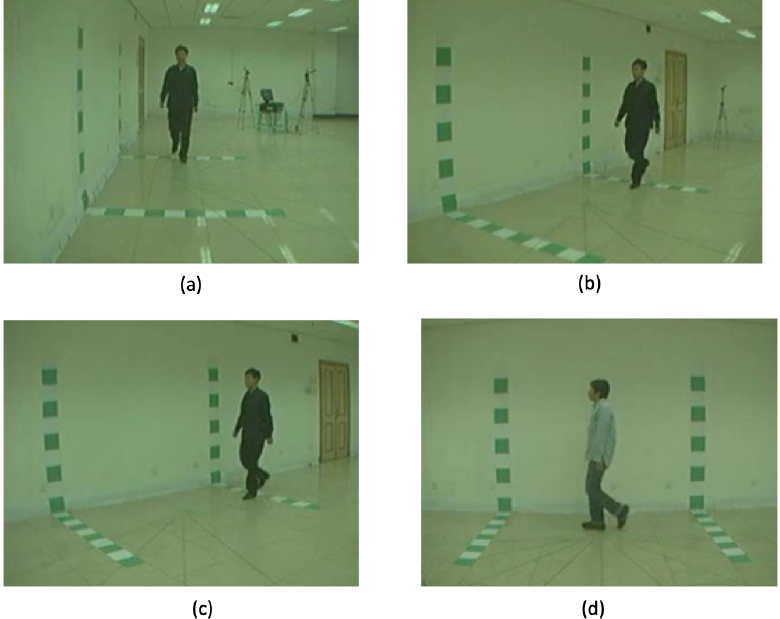
Figure 2. Scenes selected from the CASIA Gait dataset: ( a ) pedestrian walking at 0 degrees, ( b ) at 36 degrees, ( c ) at 54 degrees, and ( d ) at 90